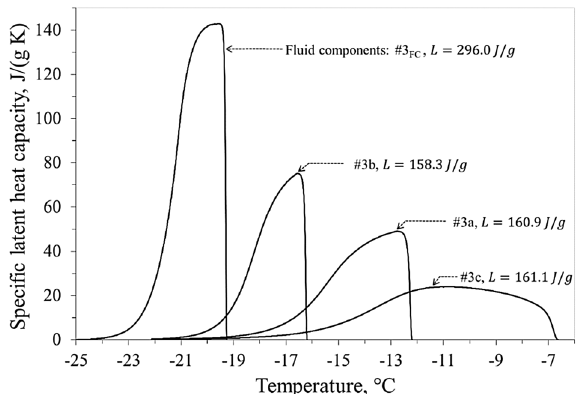
Figure 6. Equivalent specific latent heat capacity of liver samples #3a, #3b, #3c, and fluid components #3 FC .